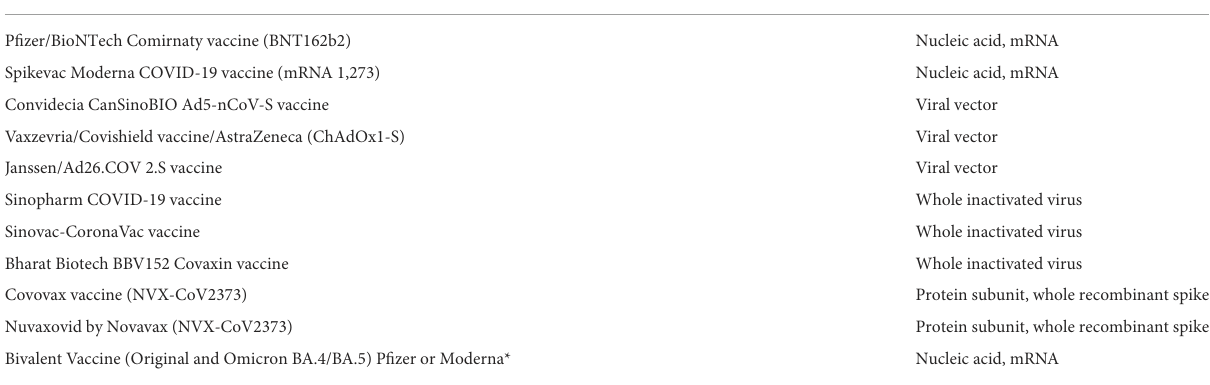
TABLE 1 Types of COVID 19